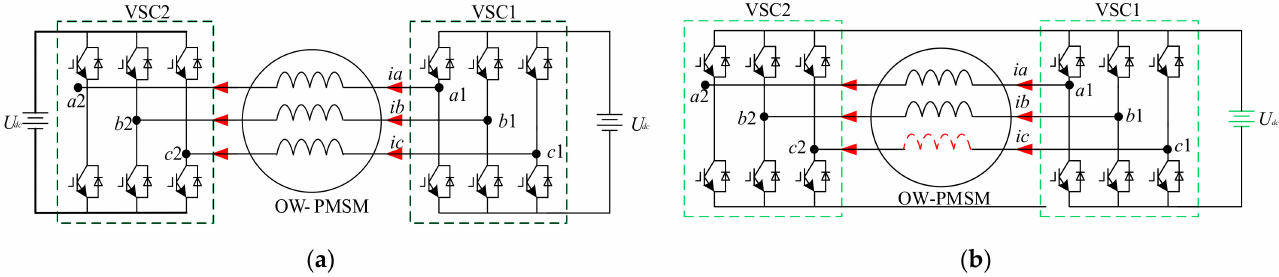
Figure 1. Topology of OW-PMSM system. ( a ) The isolation bus system; ( b ) The common DC bus